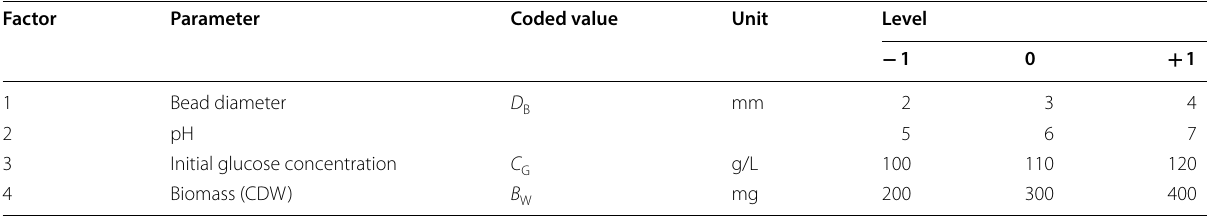
Table 2 Range of factors for LA production by immobilized L. pentosus ATCC 8041 cells